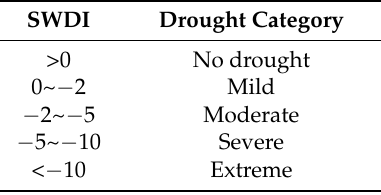
Table 1. Classification of soil water deficit index (SWDI) for different drought categories